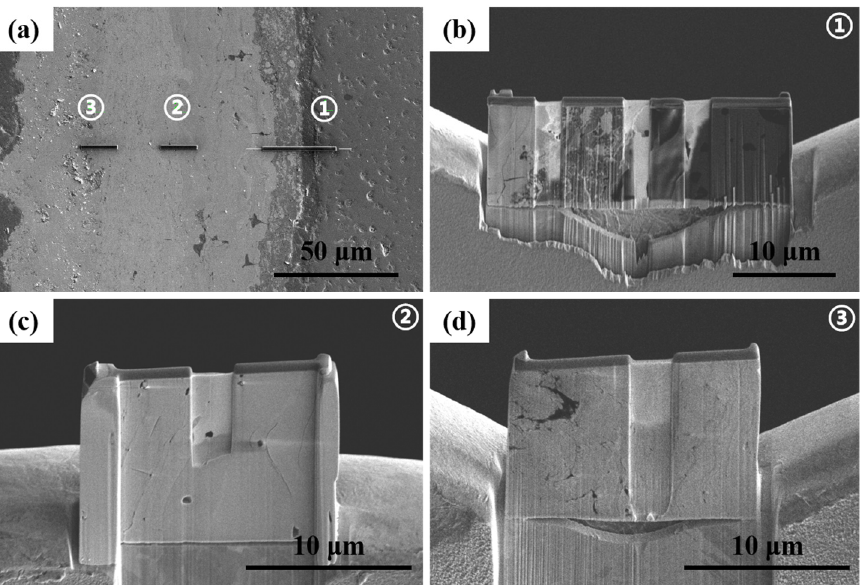
Figure 4. FIB-SEM of cross-section with T/EBCs coating: ( a ) cross-sectional peeling diagram; ( b ) po- sitions 1; ( c ) positions 2; ( d ) positions 3.